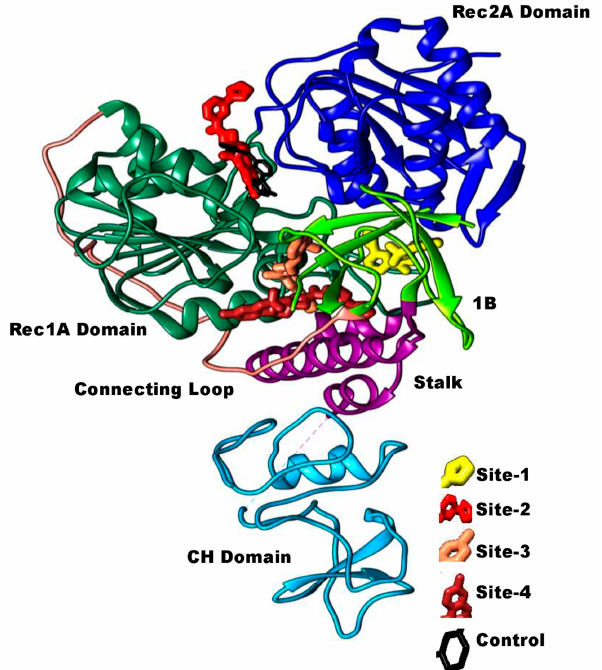
Figure 3. The different binding sites and conformation of the top ranked compound filtered in this study. Control binding site is also provided. 3.3. Comparative Chemical Interactions Analysis Next, molecular-level interactions involved in binding the compound/control at dif- ferent sites of the SARS-CoV-2 helicase enzyme were investigated to decipher the key chemical forces crucial for intermolecular binding and stability of complexes. The control Nilotinib at the ATP binding site is reported to form strong hydrogen bonds, in particular with the enzyme H9 helix residues (Gly287, Lys288, and Ser289) at Rec1A domain via its (trifluoromethyl)benzene. The rest of the compound structure stabilization is provided by medium and long range van der Waals and other hydrophobic interactions (Figure 4). The lowest binding energy conformation of the compound at site 1 is anchored at the H14-H15 helix Rec1A domain loop, with further chemical stabilization by dual hydrogen bonds with Asn557 of Rec2A via 1,2,4-triazolidine ring (Figure 5A). The predominant ATP bind- ing site (binding stie 2) of the hit compound involved mainly van der Waals bonding and alky interactions at the binding site of Rec1A and Rec2A domains throughout the length of the compound (Figure 5B). At binding site 3, the conformation of the compound pro- duces two hydrogen bonds through its 1,2,4-triazolidine ring with Glu142 stalk H5 helix,